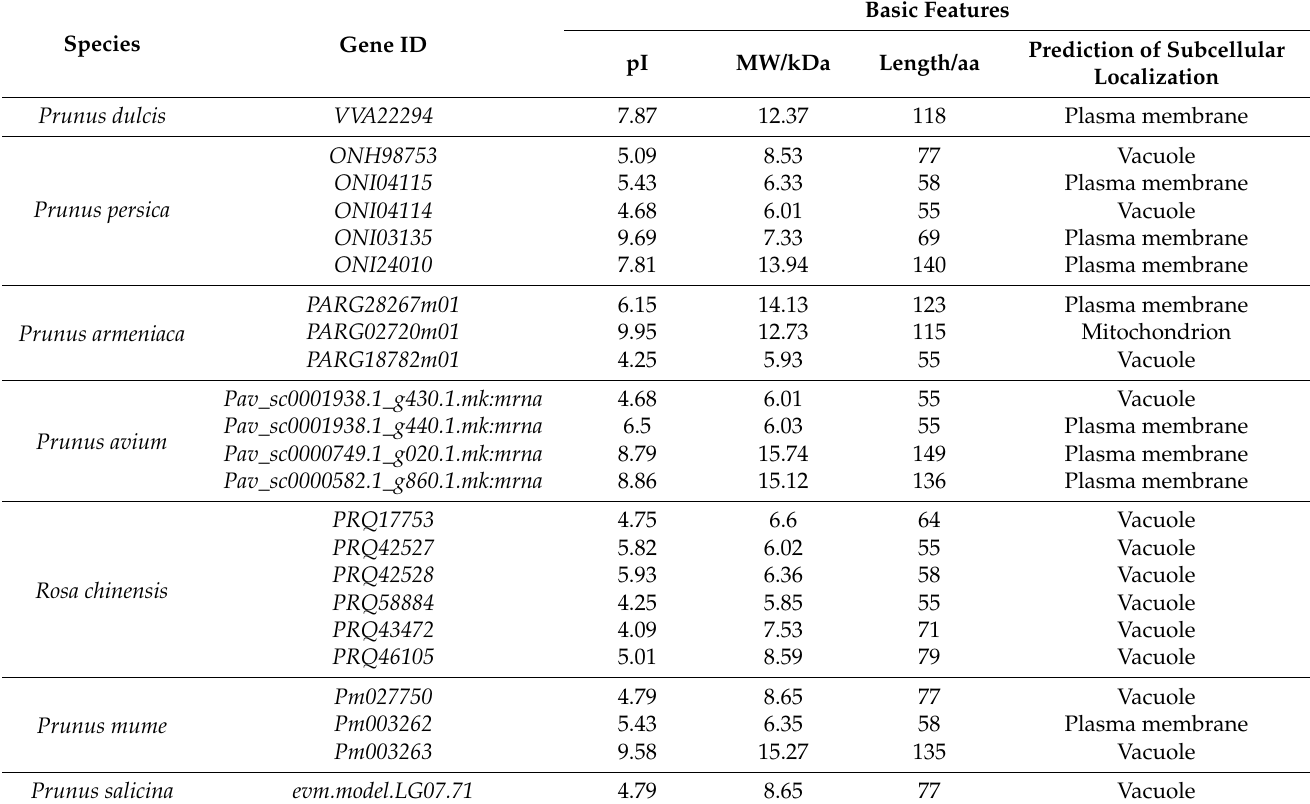
Table 1. Basic characteristics of the RCI2 gene family in seven Rosaceae